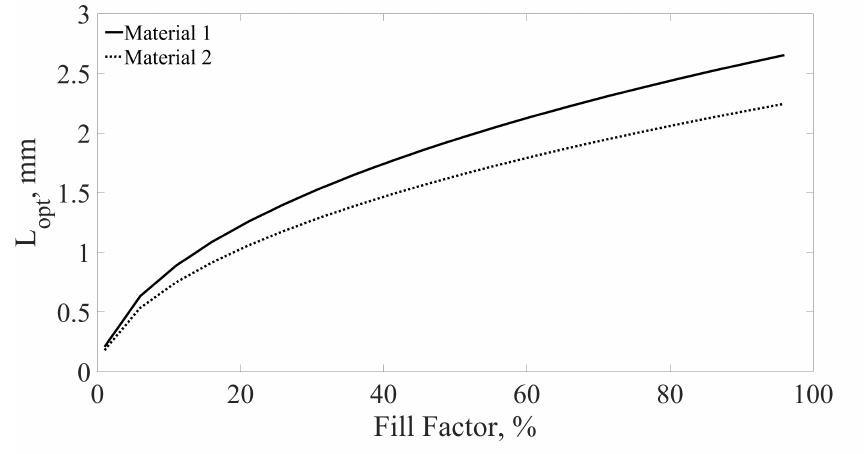
Figure 11. Optimum leg length (Equation (13)) of each TEG material in Table 6 as a function of the fill factor.